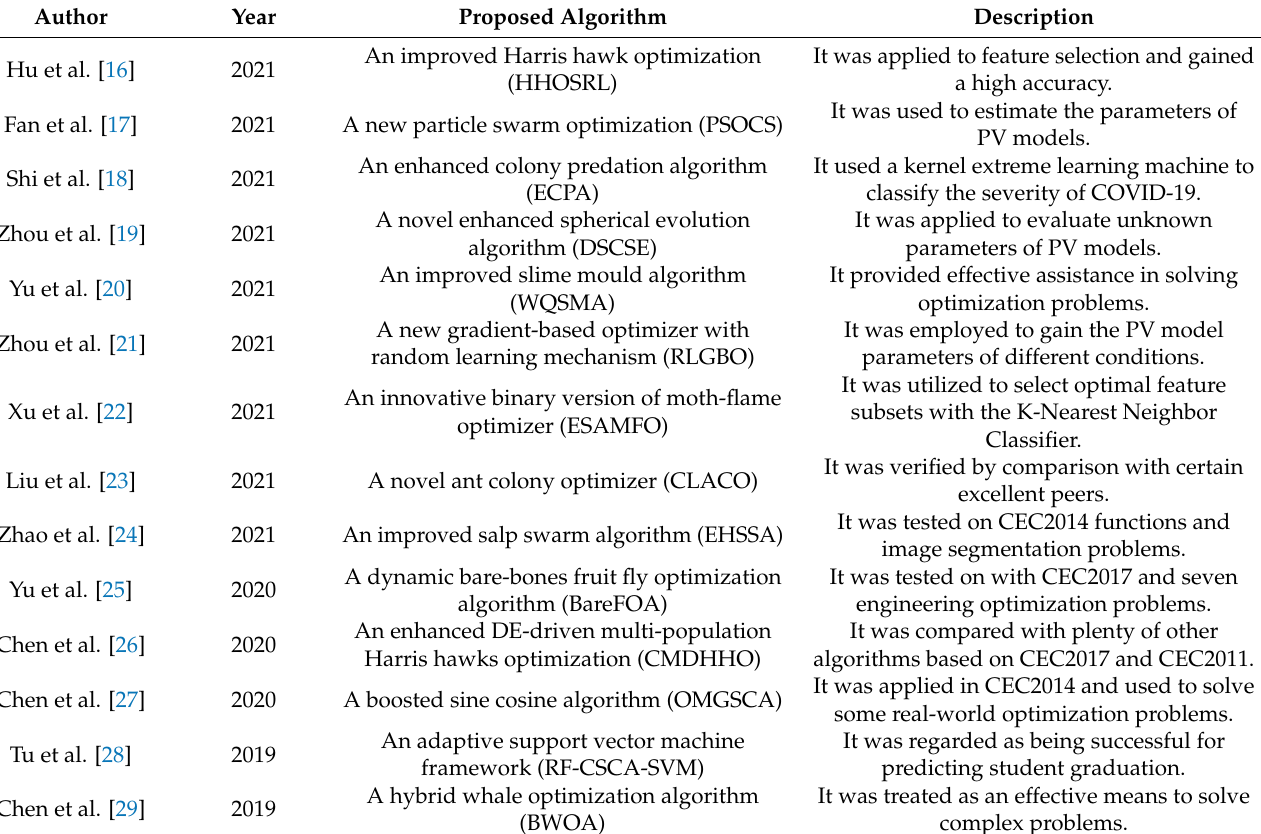
Table 1. Description of other novel improved